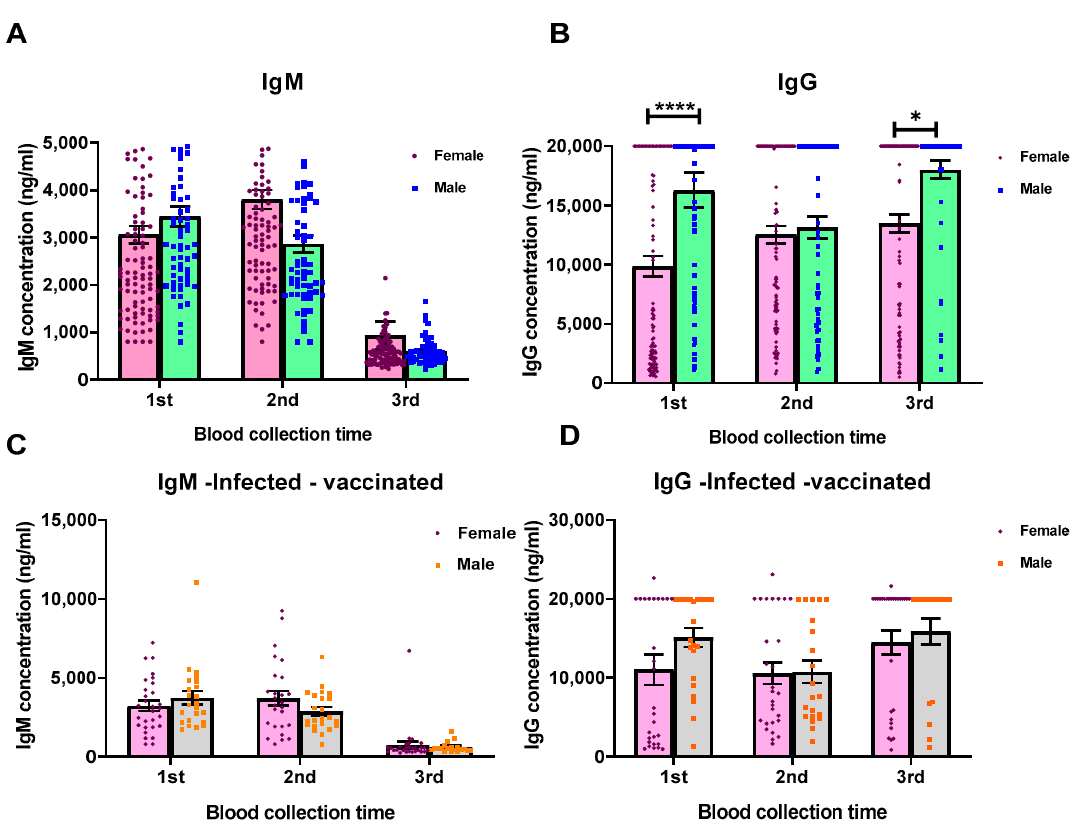
Figure 2. Comparison of the anti-spike antibody levels between male and female participants. ( A ) Anti-spike IgM levels in all male (66/173) and female (107/173) participants, ( B ) anti-spike IgG levels in all male and female participants, ( C ) anti-spike IgM levels in male (23/173) and female (29/173) participants without the history of laboratory-confirmed infection or third vaccination, and ( D ) anti-spike IgG levels in male and female participants without the history of laboratory-confirmed infection or third vaccination. * p value 0.02 and **** p value < 0.0001.